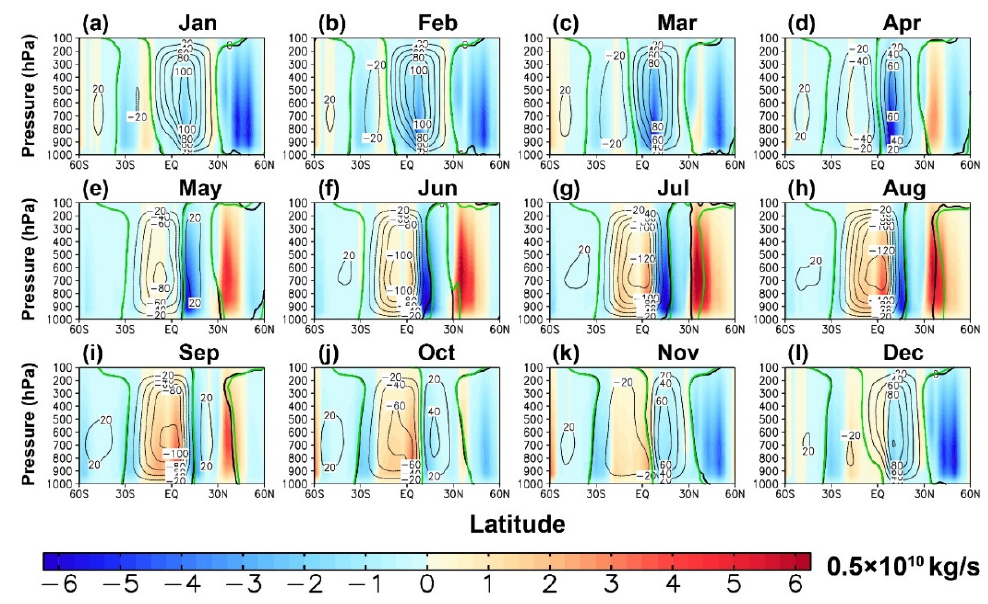
Figure 5. Same as Figure 3 but for the results derived from M3.